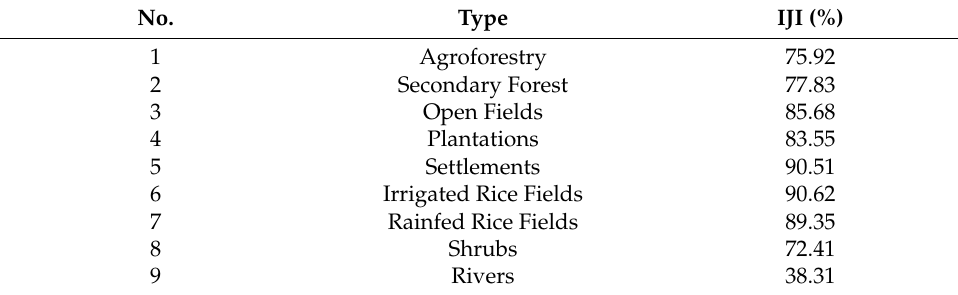
Table 9. Calculation results of IJI metric at the class level. No.